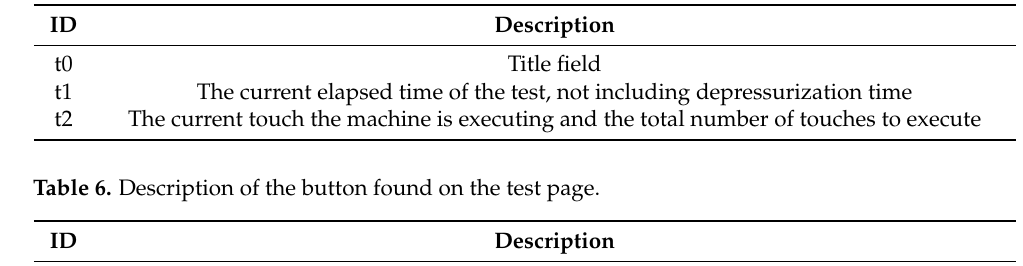
Figure 4. Test page as it appears during a test. Table 5. Description of each text field found on the test page.